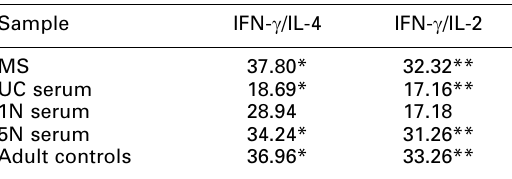
Table 3. Cytokine ratios during the perinatal and early neonatal period